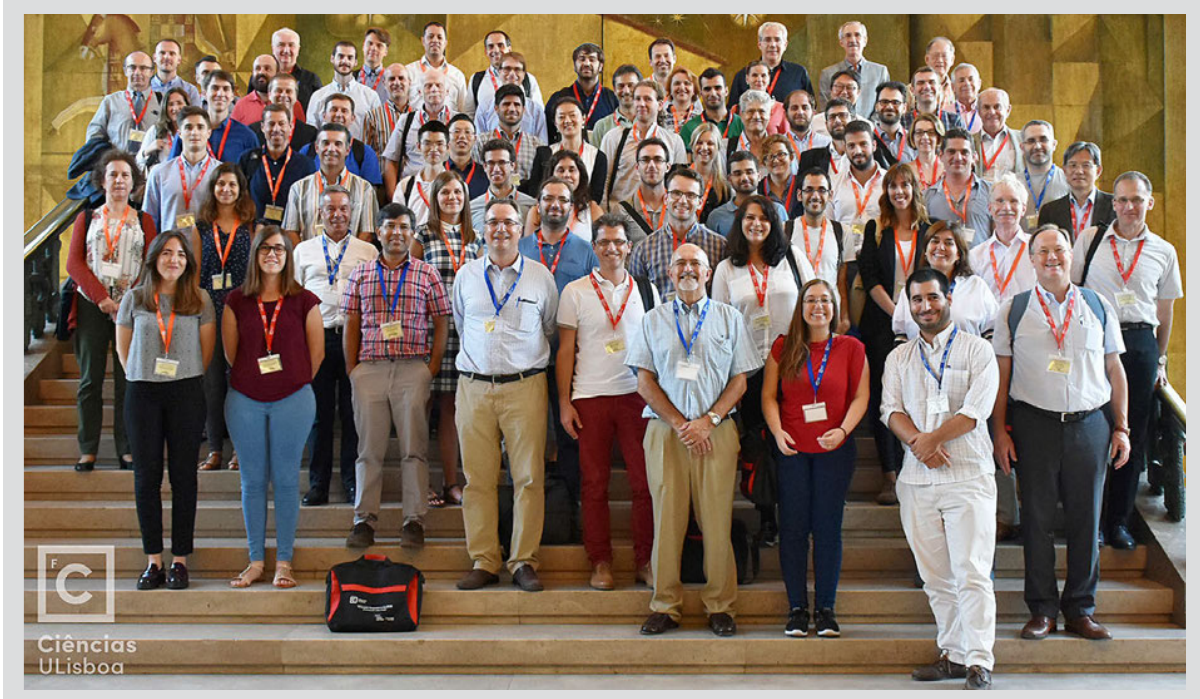
Figure 1: Participants at the symposium.